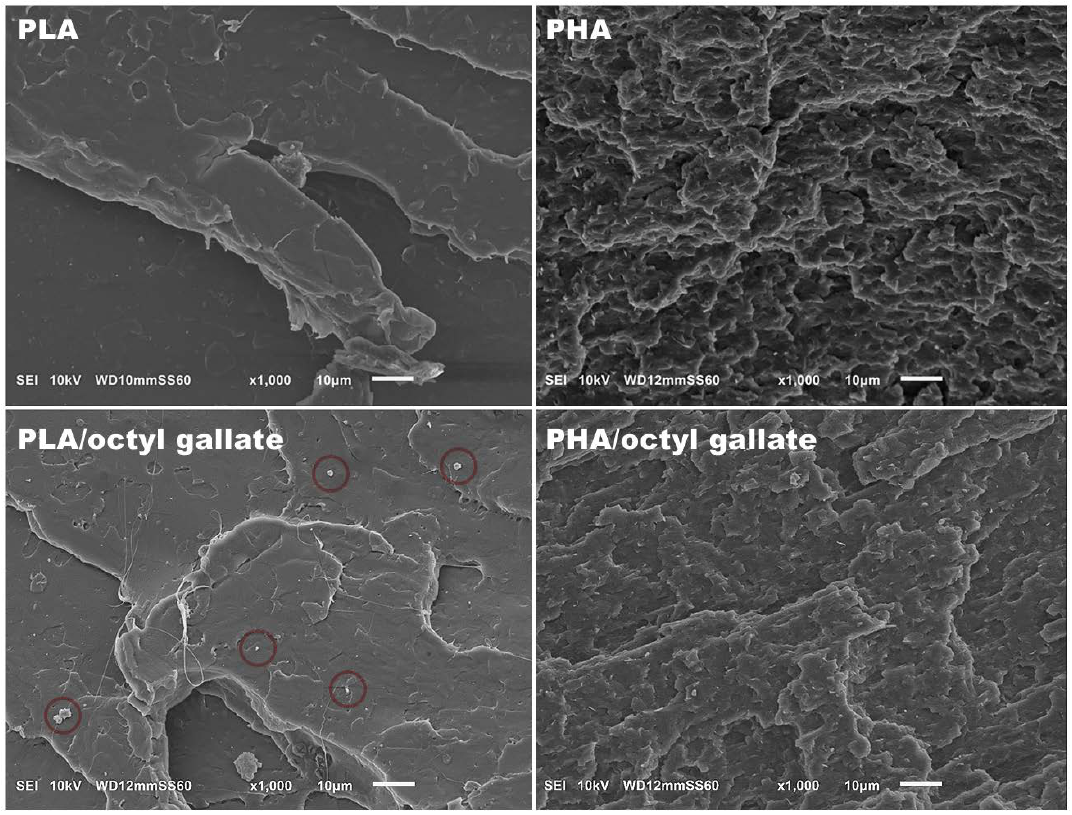
Figure 4. Scanning electron microscope (SEM) photographs of polyesters.